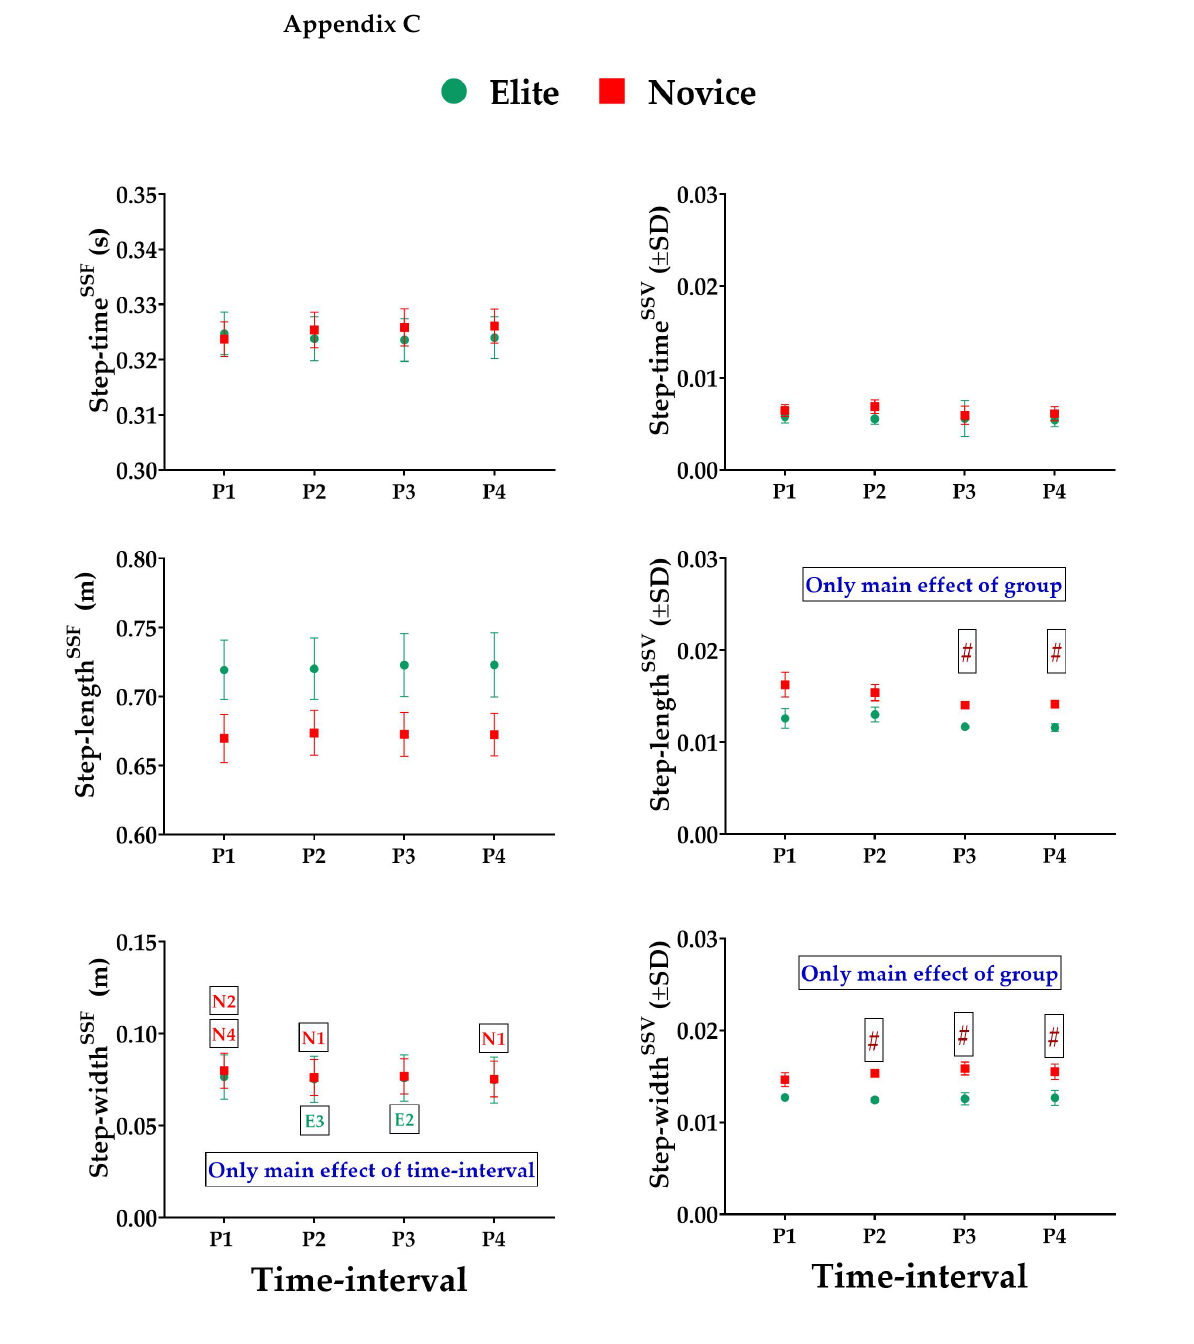
Figure A1. The results of SSF ( left ) and SSV ( right ) of spatiotemporal variables between elites (circle) and novices (square) in each phase of the prolonged run are shown. The computed variables are represented on the Y -axis. The time interval was computed by increasing the window size every five minutes, as seen on the X -axis. (P1: 0 to 5 min; P2: 0 to 10 min; P3: 0 to 15 min; and P4: 0 to 20 min). The graph depicts a statistically significant main effect of group, time interval, and interaction. The outcome of a pairwise comparison for the time-interval difference is represented by letters (N for novice and E for the elite) with the corresponding time-interval with a significant difference (e.g., N1 for the novices at time interval 0–5 min). Significant differences between groups for a specific time interval are marked with a